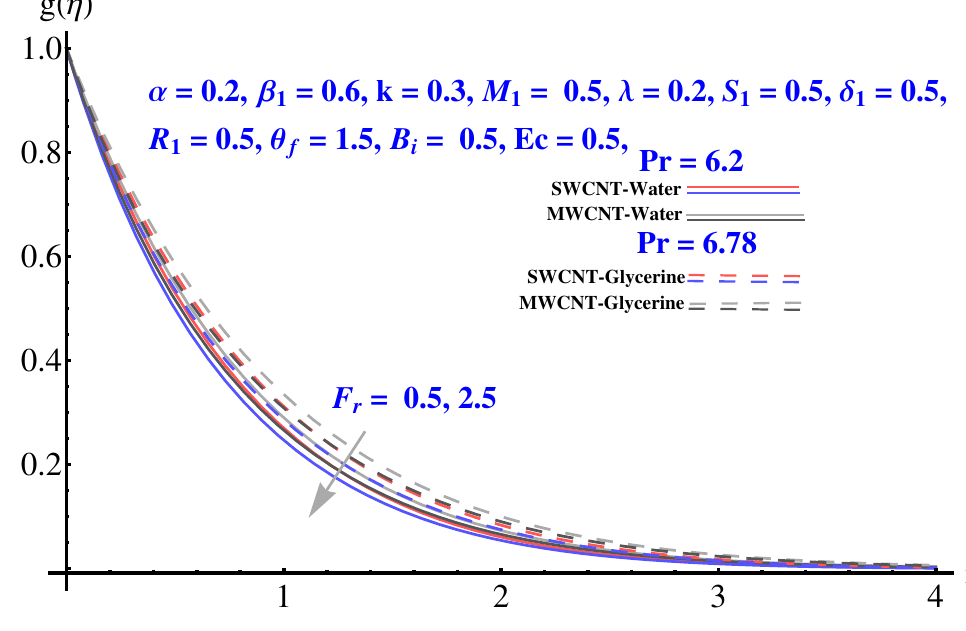
Figure 9. Impact of Fr on tangential velocity.